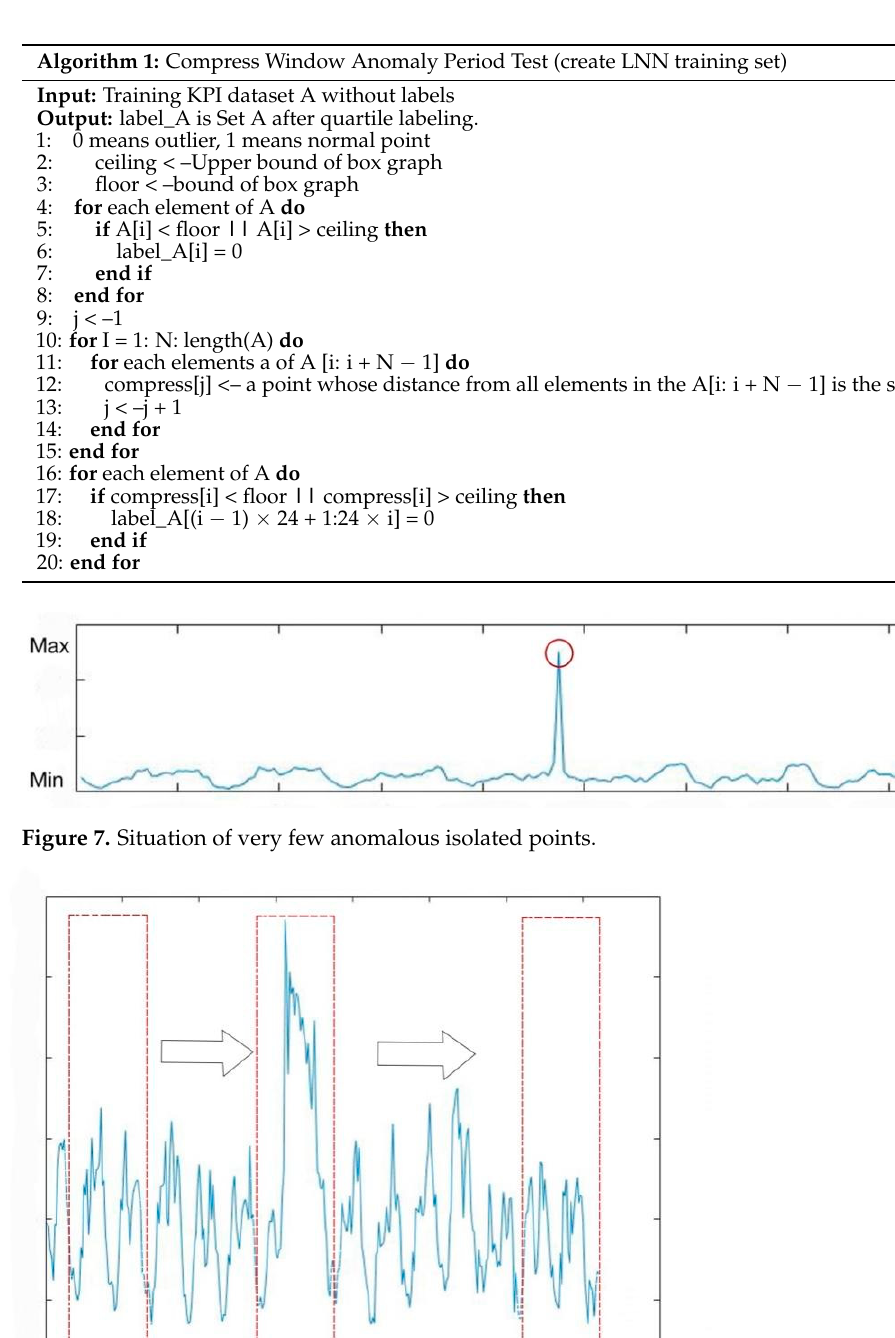
Figure 9. Structural diagram of neural network. The main idea of labeling neural networks is to divide the learning process into two stages. The first stage is a forward-propagation process that gives the input information, which is processed layer by layer through the input layer by the implicit layer and calcu- lates the actual output value of each cell. The second stage is the error back-propagation process, where the difference between the actual output and the desired output (i.e., the error) is recursively calculated layer by